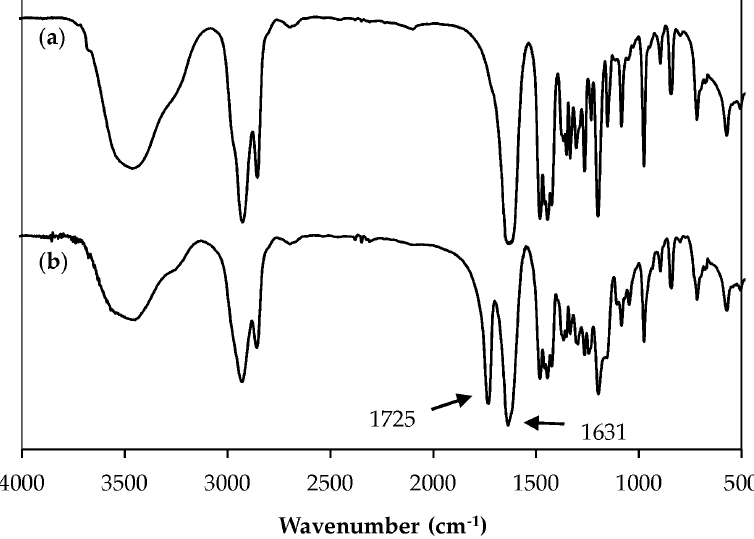
Figure 5. FTIR spectra of ( a ) PNVCL–OH and ( b ) PNVCL- b -PCL (1).